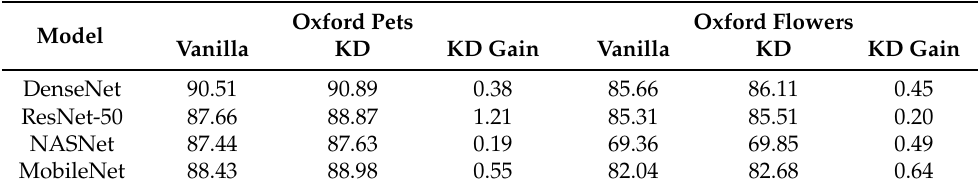
Table 4. Transfer learning results on Oxford Pets [26] and Oxford Flowers datasets [27].